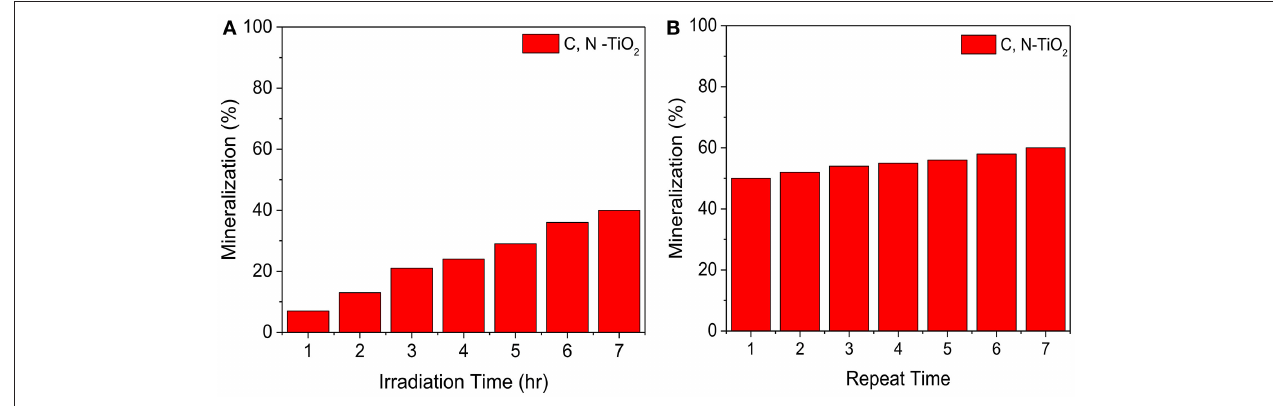
FIGURE 5 | (A) TOC after 7h degradation (B) TOC after multiple degradation.